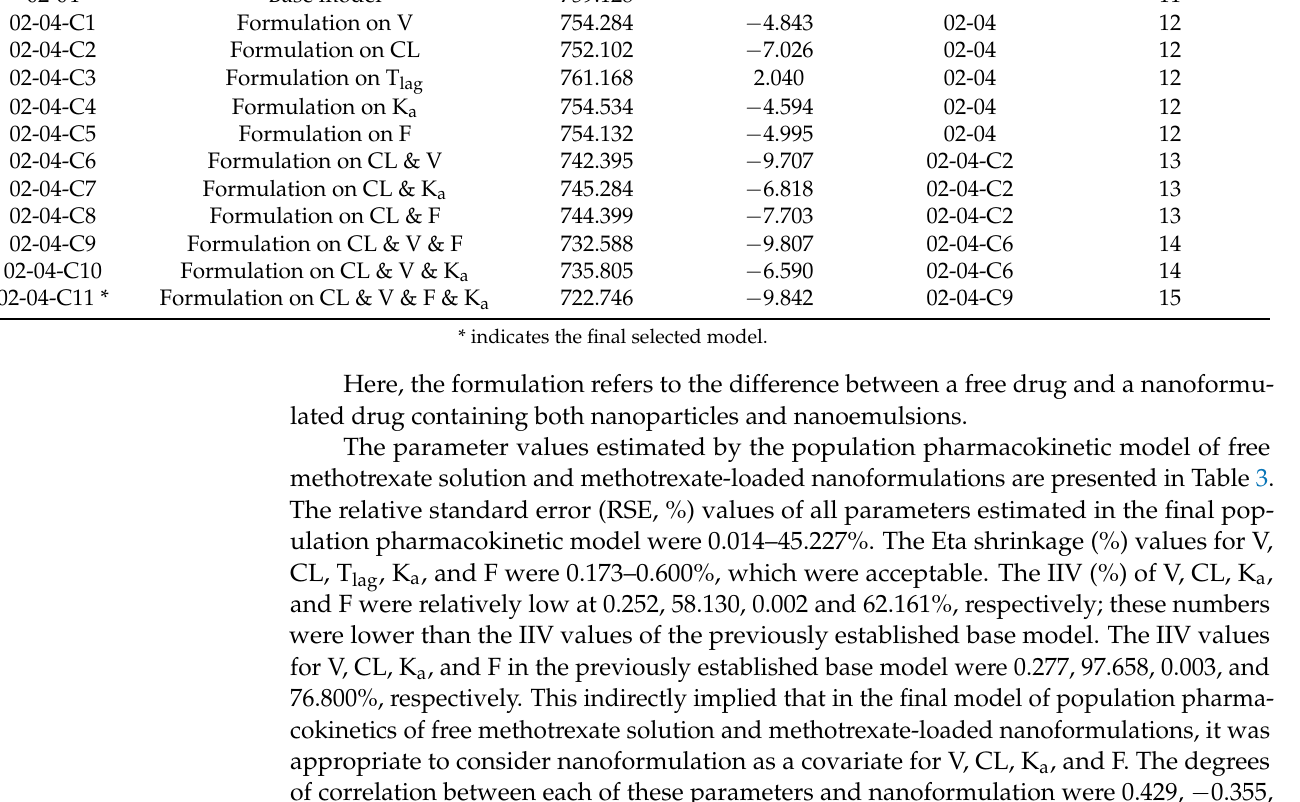
Table 2. Stepwise search for covariates in the models of free methotrexate solution and methotrexate-loaded nanoformulations.